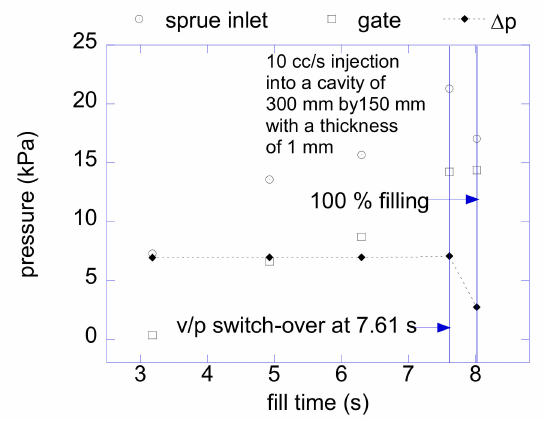
Figure 2. Pressure drop over the filling time at 100 cc/s